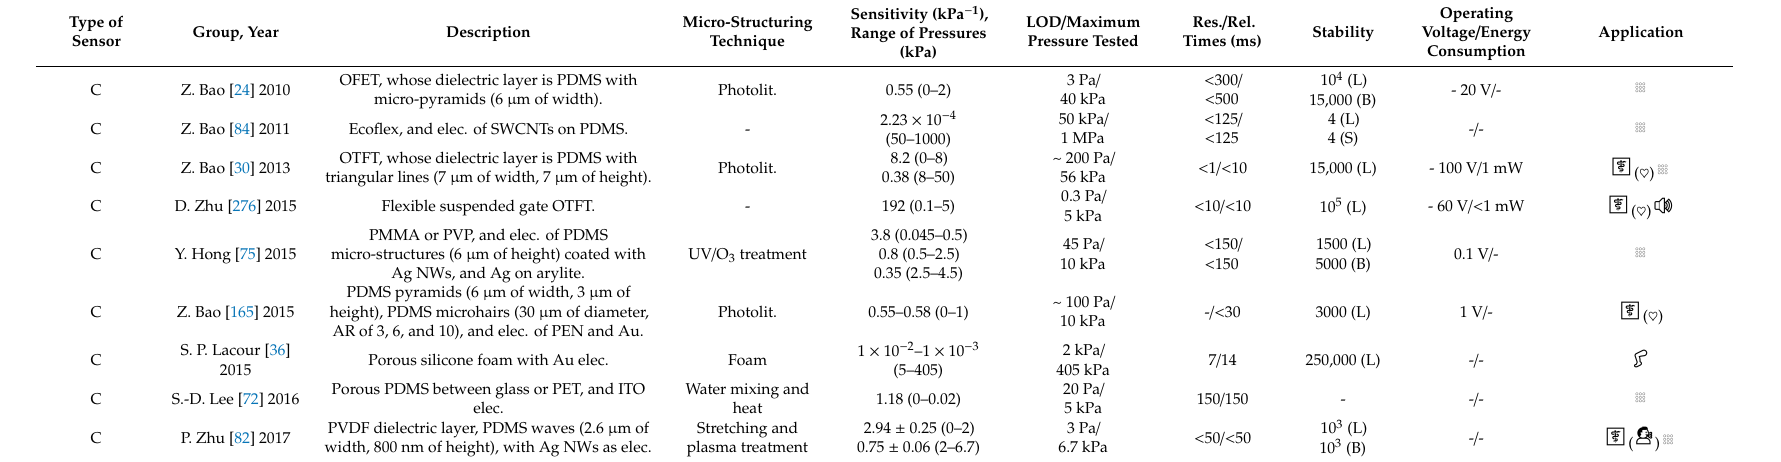
Table B1. Features of state-of-the-art pressure sensors based on capacitance (C), piezoelectricity (PE), piezoresistivity (PR), and triboelectricity (TE). “Stability” is the number of loading (L), stretching (S), or bending (B) cycles the sensor was subjected. Symbols: 🌬 —Breathing; 🦵 —Functional Prosthesis; ⚕ — Health Monitoring; 💻 —Human Machine Interfaces; 💪 —Muscle Movements; 𓃑— Pressure Mapping; ♡ —Pulse wave pressure at the wrist/neck/arm/ankle/head or heart rate; ⚙ — Robots; 🔊 —Sound monitoring; 🗣 —Speech; 🌡 —Temperature Mapping or Monitoring; — Vibration Monitoring; 👣 —Walking.